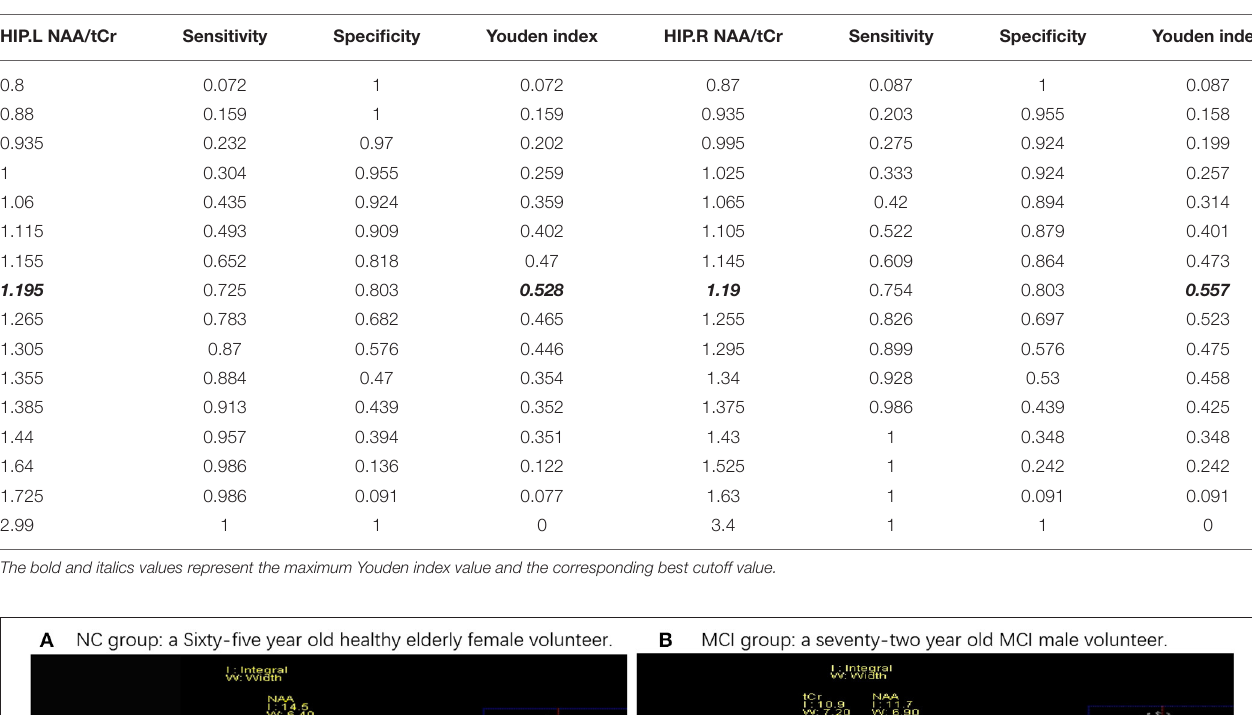
TABLE 5 | Sensitivity, specificity, and the Youden Index (YDI) corresponding to each point of the ROC curve in the left HIP and the right HIP. HIP.L NAA/tCr